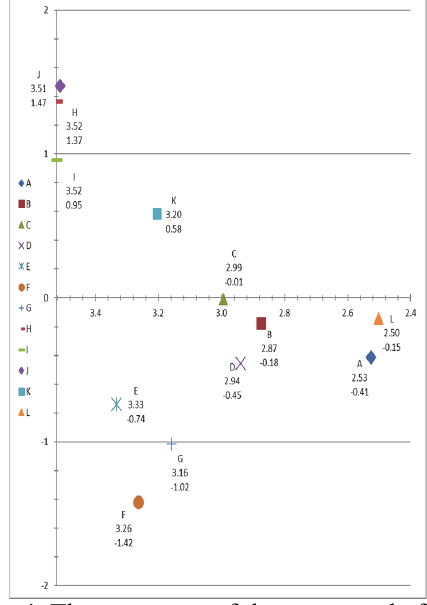
Fig. 4. The summary of the cause and effect